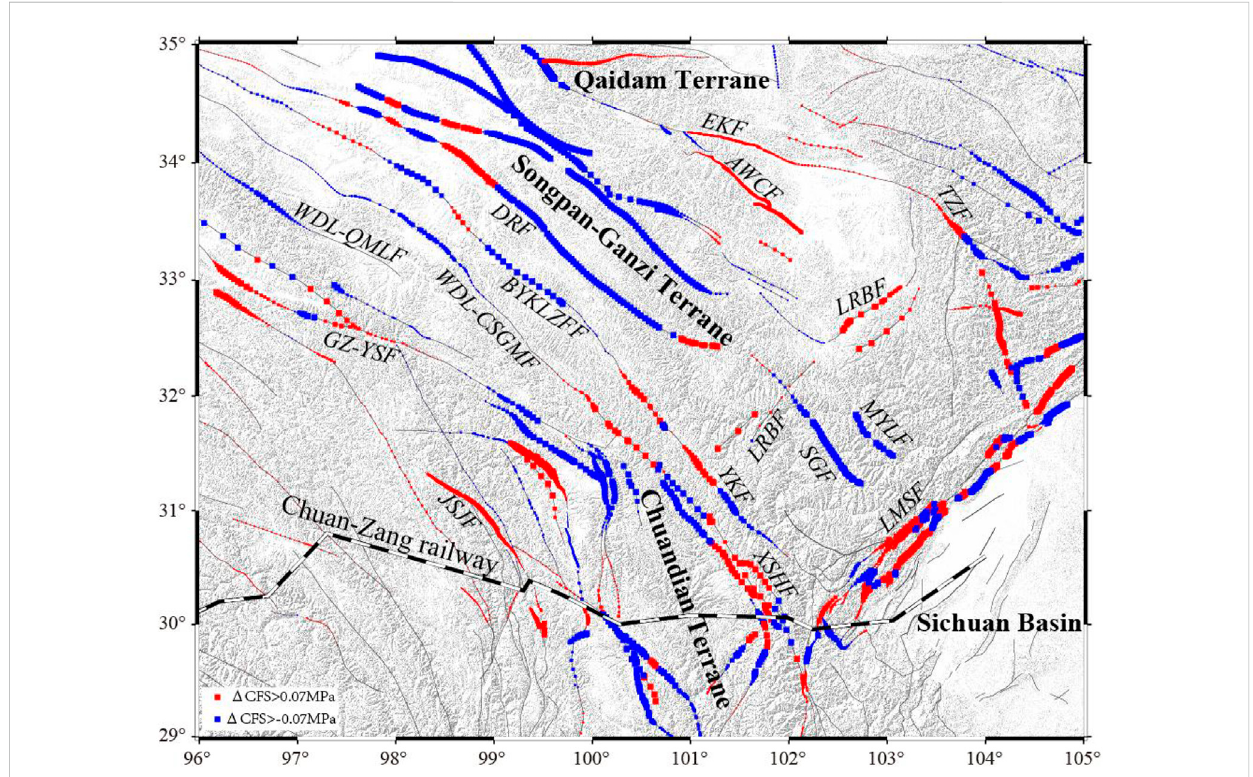
FIGURE 9 Contour map of the Coulomb stress change along faults around the Songpan – Ganzi Terrane effected by historical earthquakes. Abbreviations of major faults: East Kunlun Fault (EKF), Tazan Fault (TZF), Wancang Fault (AWCF), Dari Fault (DRF), Longba Fault (LRBF), Wudaoliang – Qumalai Fault (WDL- QMLF), Wudaoliang – Changshagongma Fault (WDL-CSGMF), Bayankalazhufeng Fault (BYKLZFF), Ganzi – Yushu Fault (GZ-YSF), Miyaluo Fault (MYLF), Songpan – Ganzi Fault (SGF), Jinshajiang Fault (JSJF), Yuke Fault (YKF), Xianshuihe Fault (XSHF), Longmenshan Fault (LMSF), Sichuan ‒ Tibet railway (Chuan-Zang